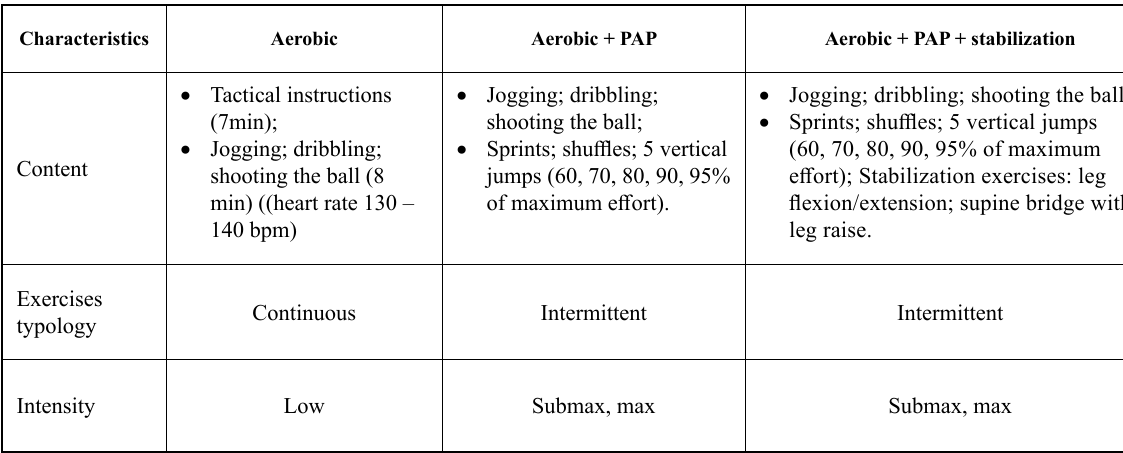
Table. Different half-time re-warm ups schemes Characteristics